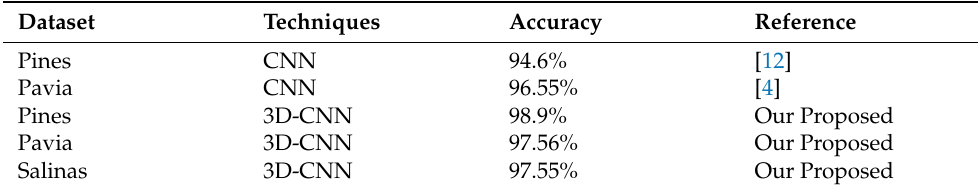
Table 2. Comparison with other